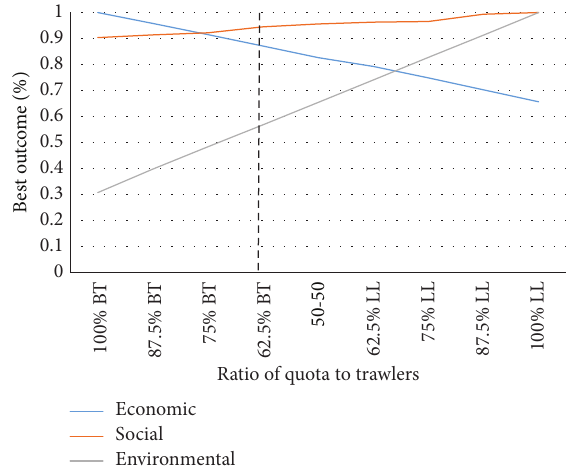
Figure 7: Main results from running simulations with different quota allocations. To the far left we display the case where the entire quota under consideration is allocated to bottom trawlers and the far right shows the opposite case with the entire quota allocated to